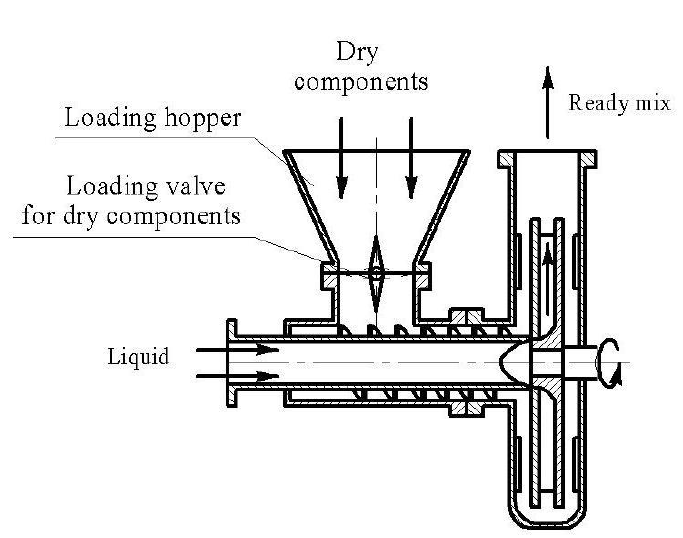
Figure 1. Installation diagram for the preparation of liquid feed mixtures .